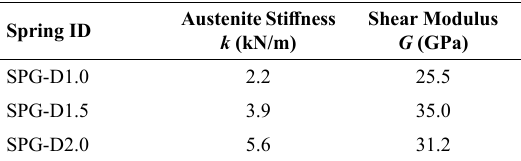
Table 4. Measured stiffness and calculated shear modulus of the Ni-Ti SMA superelastic helical springs. Austenite Stiffness Shear Modulus Spring ID k (kN/m) G (GPa) SPG-D1.0 2.2 25.5 SPG-D1.5 3.9 35.0 SPG-D2.0 5.6